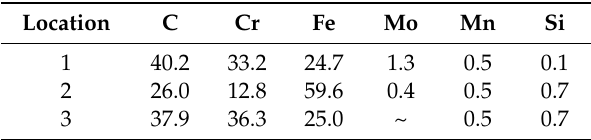
Figure 3. Microstructure and line scanning results of multilayered steel. ( a ) macro-feature of the MLS, ( b )the magnification of ML in Figure 3a, ( c ) the magnification of the composite layer at two sides in Figure 3a, ( d ) line scanning distribution location, ( e ) line scanning result along the black line OA in Figure 3d, ( f ) EBSD phase analysis, ( g ) the misorientation distribution obtained by EBSD. Table 2. Main chemical composition of carbides in Figure 3d.